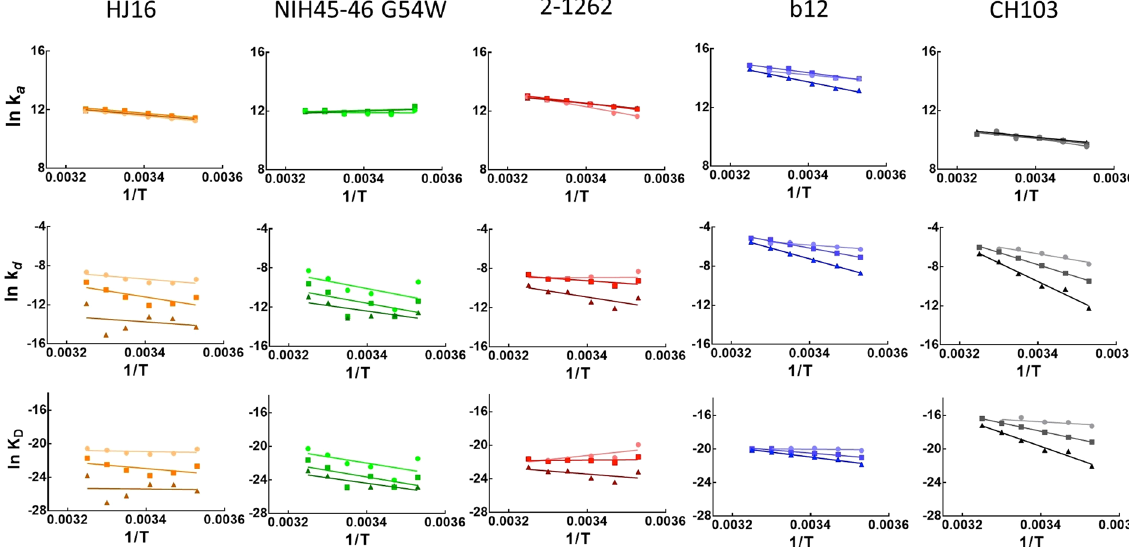
Figure 4. Temperature dependences of binding kinetics and of K D of Abs specific for CD4-binding site of gp120 – HJ16 (orange), NIH45-46 G54W (green), 2-1262 (red), b12 (blue) and CH103 (black). The different intensities of colors correspond to differences in the immobilization density of gp120 CN54, namely pale: 0.2 ng/mm 2 , median: 1 ng/mm 2 and intense: 4.8 ng/mm 2 . The Arrhenius plots were generated by linear regression analyses. The values of R 2 of the presented fits are as follows: (1) HJ16, k a , low density (l.d.): 0.9856, median density (m.d.): 0.9731 and high density (h.d.): 0.9661; k d , l.d.: 0.5940, m.d.: 0.5581 and h.d.: 0.06745;